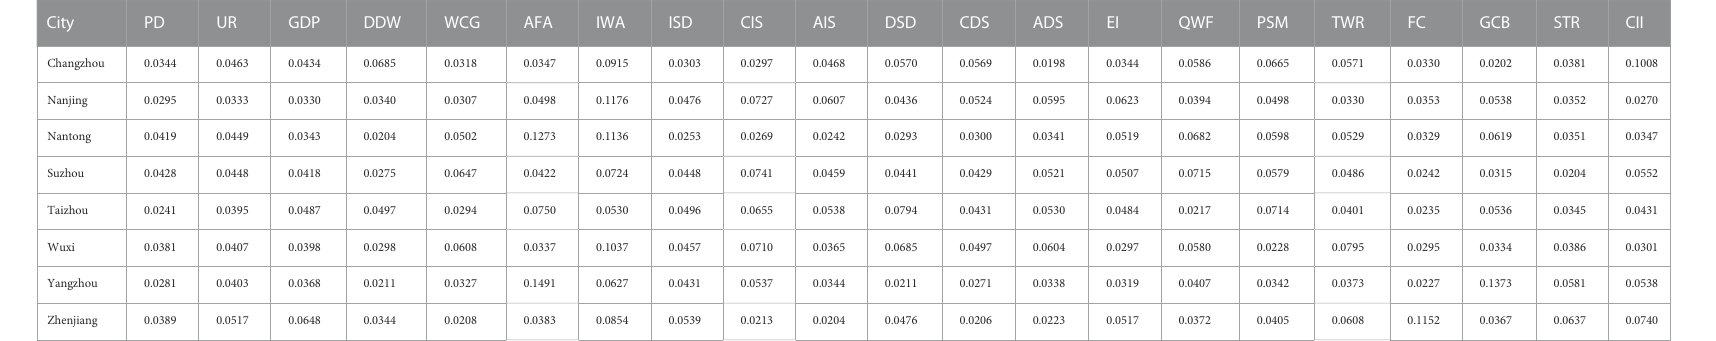
TABLE 7 Entroy weights of indicators in different